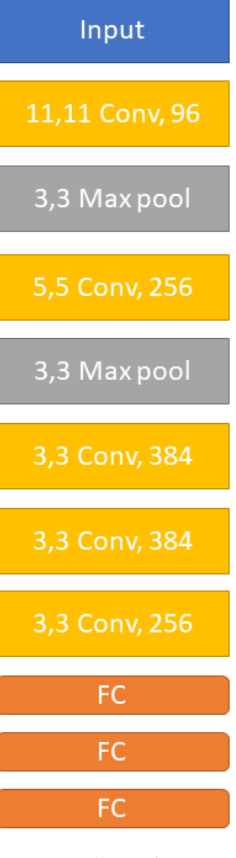
Figure 3. The architecture of the AlexNet deep CNN (FC = fully connected layer, Conv = convolu- tional layer, Max pool = max pooling layer).